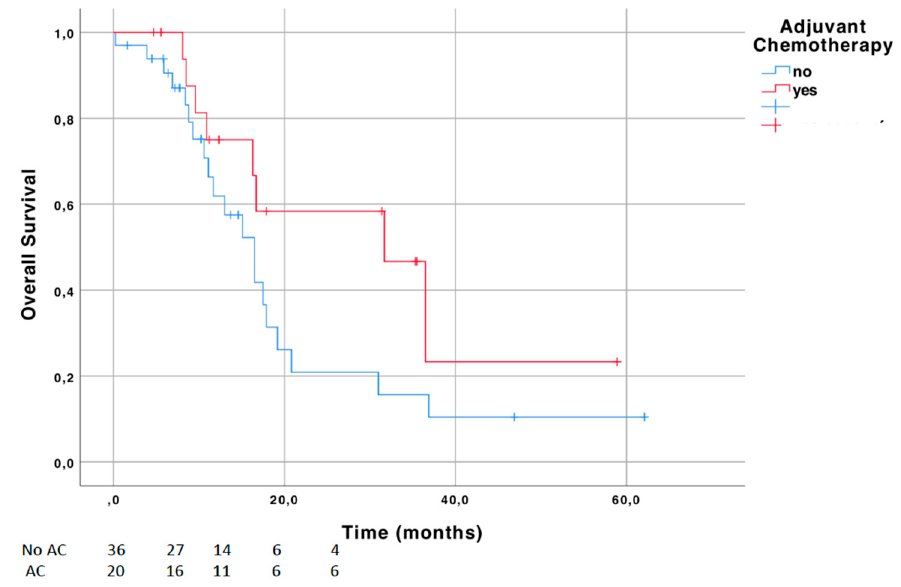
Figure 2. Survival curves for overall survival (OS) in the neoadjuvant chemotherapy (NAC) cohort stratified by the use of adjuvant chemotherapy (AC).